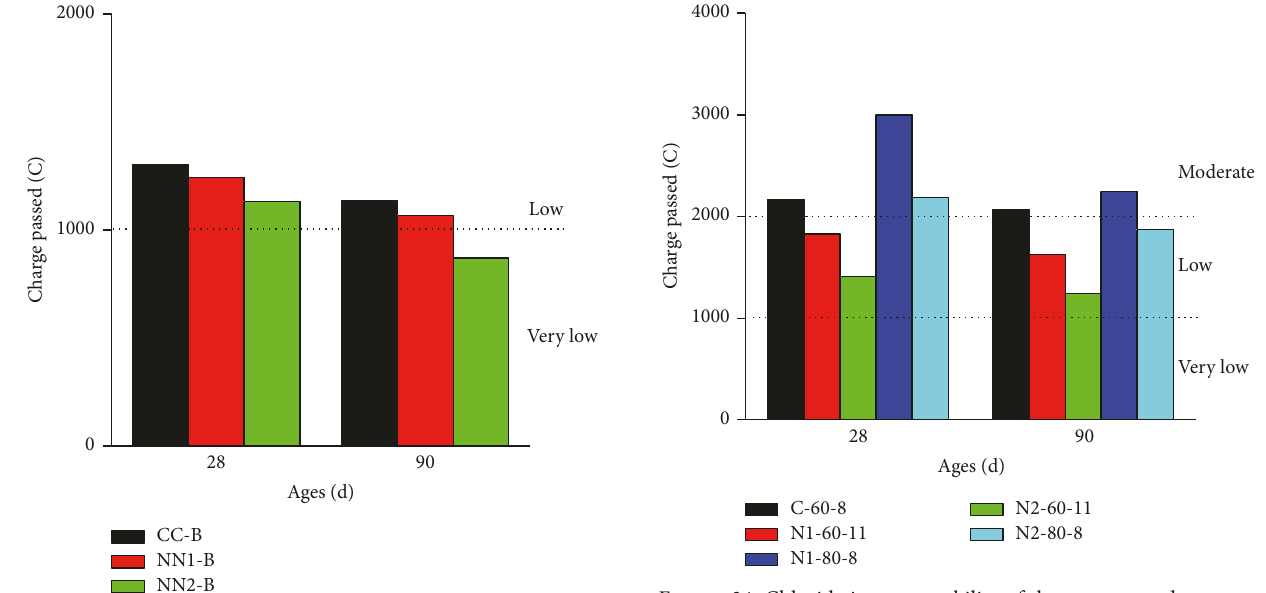
Figure 24: Chloride ion permeability of the steam-cured concrete with W/B of 0.40.